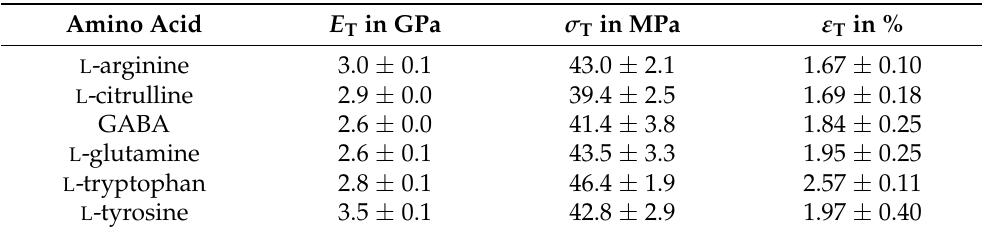
Figure 4. Stress–strain curves derived from tensile tests of amino-epoxides. Table 3. Young’s modulus E T , tensile strength σ T , and fracture strain ε T of amino-epoxides (average ± standard